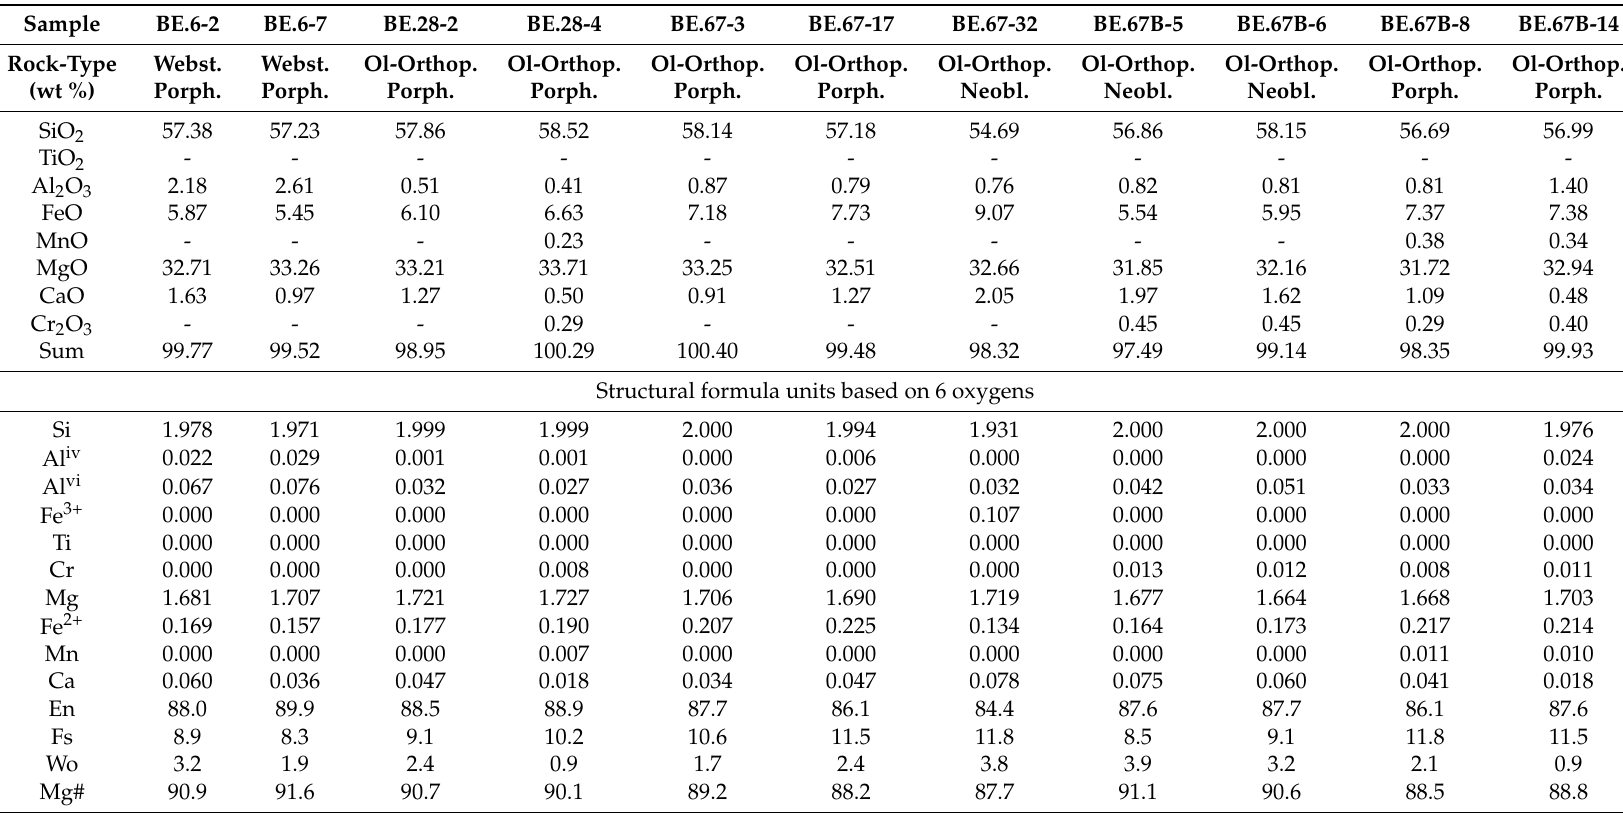
Table 1. Representative electron microanalyses of orthopyroxenes from the Veria-Naousa pyroxenites (Porph.: porphyroclast, Neobl.: neoblast, -: below detection